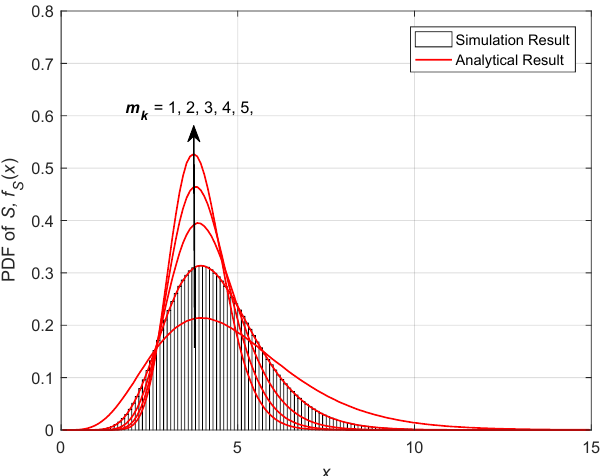
Figure 2. PDF of S , f S ( x ) , for various values of m k when M = 6, K = 3, and γ =